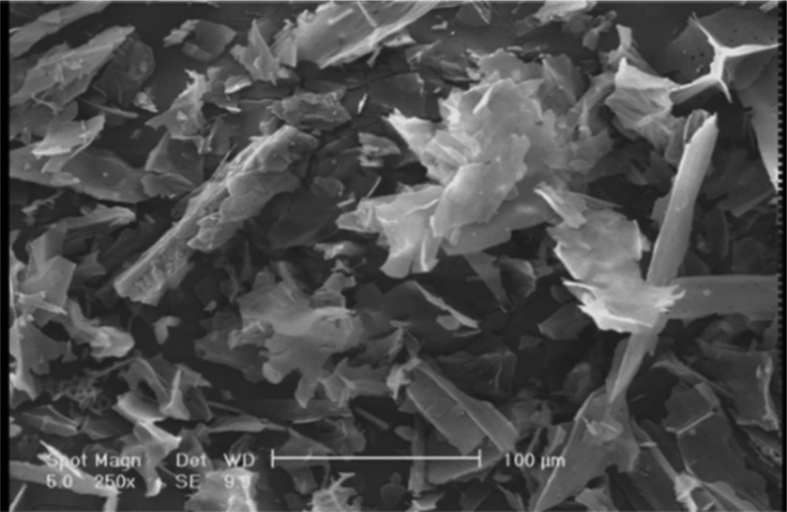
SEM images of prepared activated carbon from corn waste.